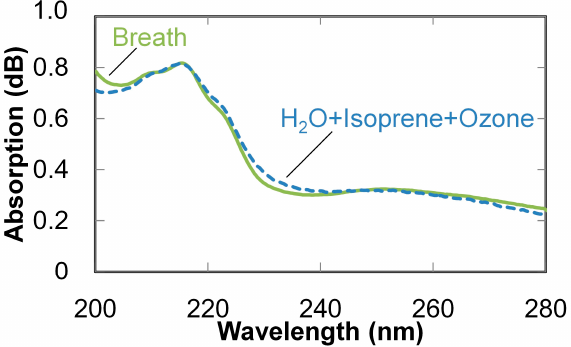
Figure 10. Calculated absorption spectrum of a mixed gas of isoprene, water, and ozone (whose concentrations were estimated from the measured spectrum of breath, also shown for comparison).